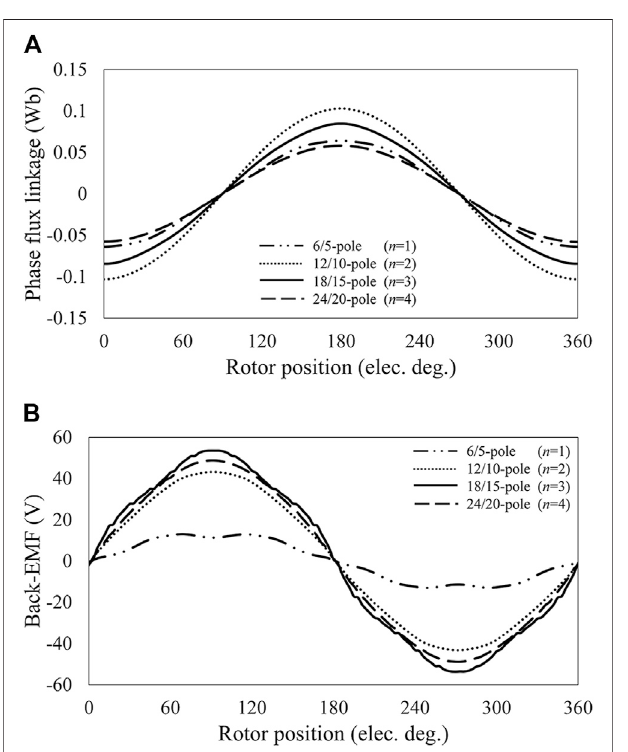
FIGURE 4 | The waveforms of (A) phase fl ux linkage and (B) phase back-EMF of the proposed DSPM structures.